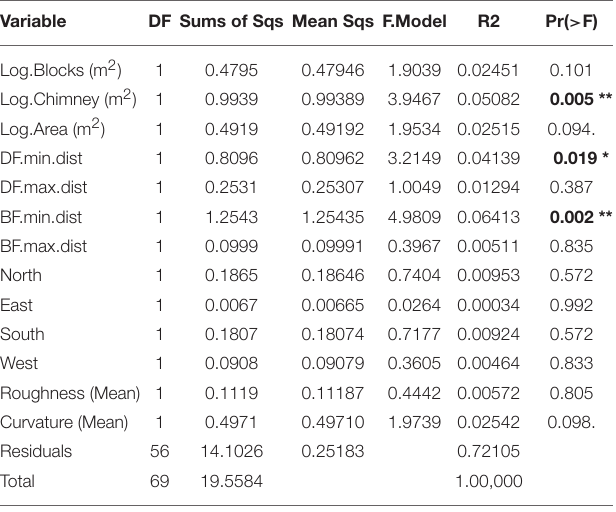
TABLE 3 | Significance value derived from the permutational multivariate analysis of variance (adonis) of all used terrain variables. Variable DF Sums of Sqs Mean Sqs